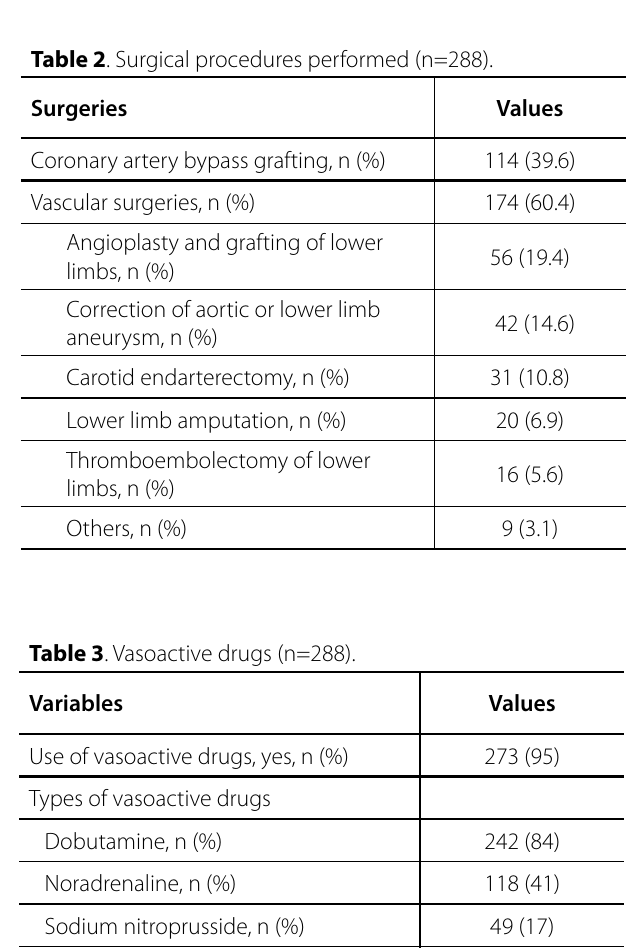
Fig. 1 – Incidence of diabetes mellitus and other cardiovascular risk factors.